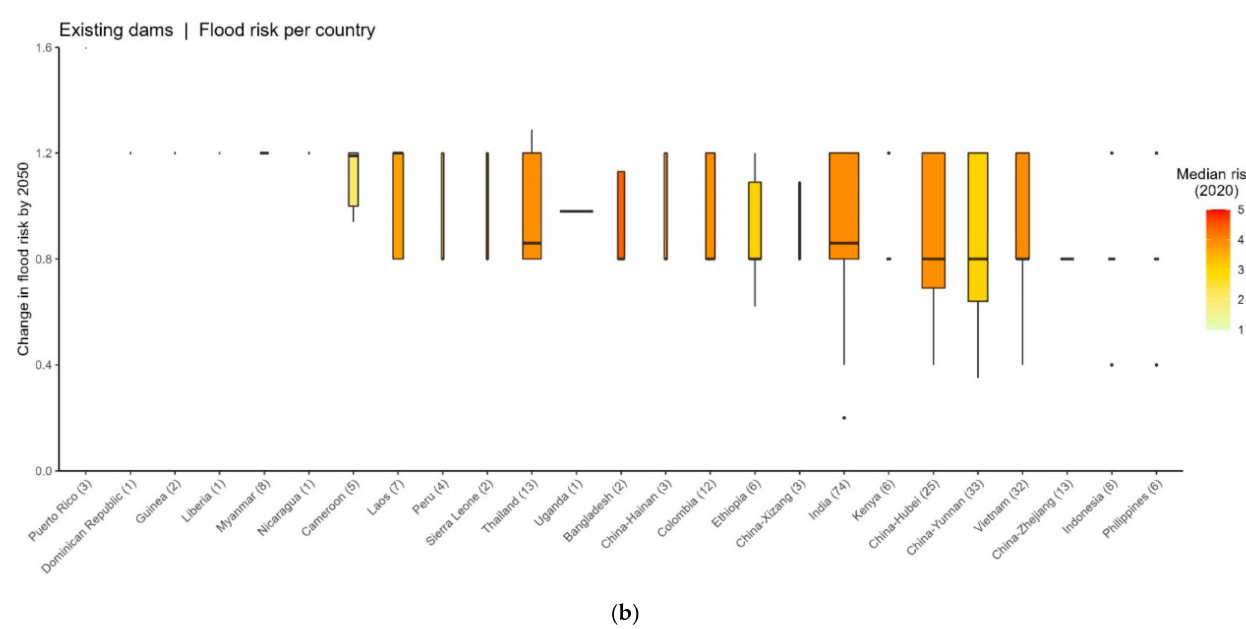
Figure 6. ( a ) Distribution of existing dams with color indicating the projected change in relative flood risk in 2050 under the pessimistic scenario. The size of the circle reflects the hydropower capacity of the dam. See the interactive version of this map at https://rcamargo.shinyapps.io/ HydropowerClimateChange; (accessed 21 January 2022). ( b ) Change in flood risk (vertical axis) for existing hydropower dams by 2050 according to country or subnational region under the pessimistic scenario. Bar color indicates current risk and width indicates aggregate hydropower capacity.